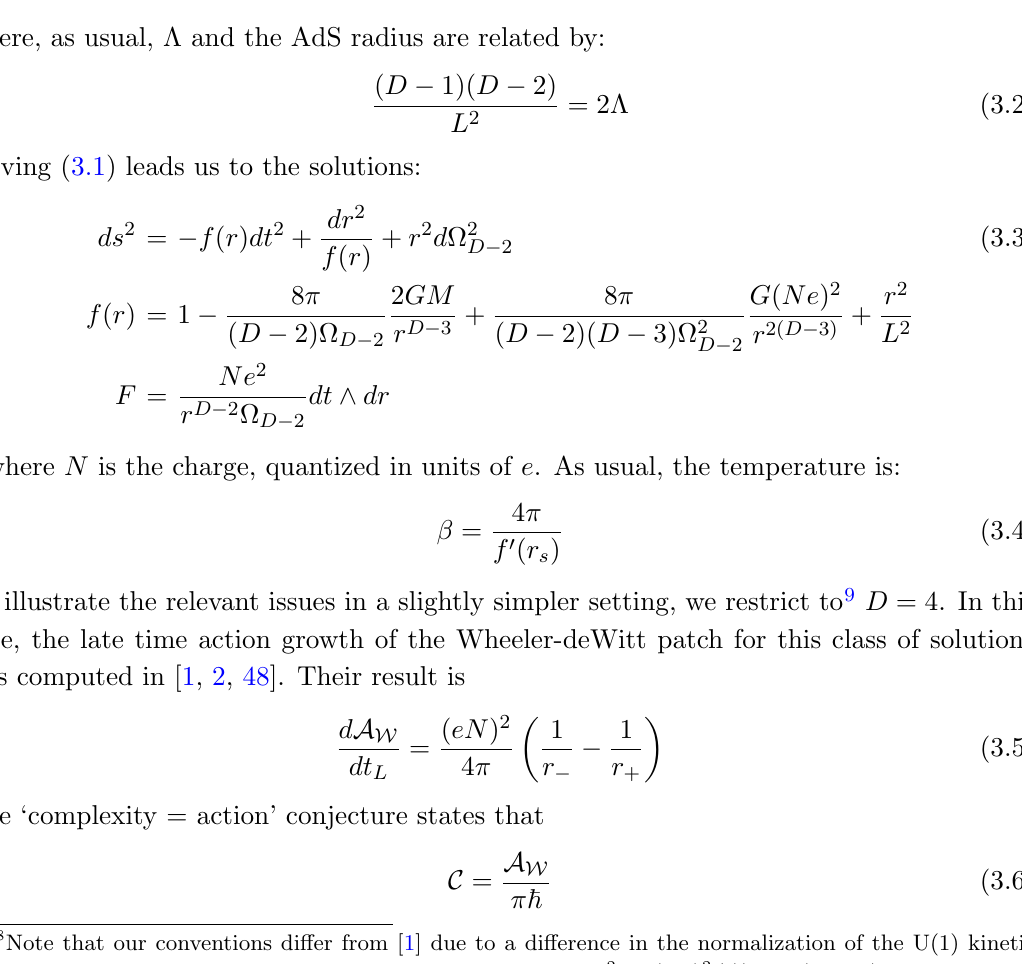
Figure 2 . Illustration of Wheeler-DeWitt patch in the neutral AdS-Schwarzschild black hole for a pair of times ( t L ; t R ). The patch is de(cid:12)ned by the intersection of both future and past-directed light rays from both boundary points, and the